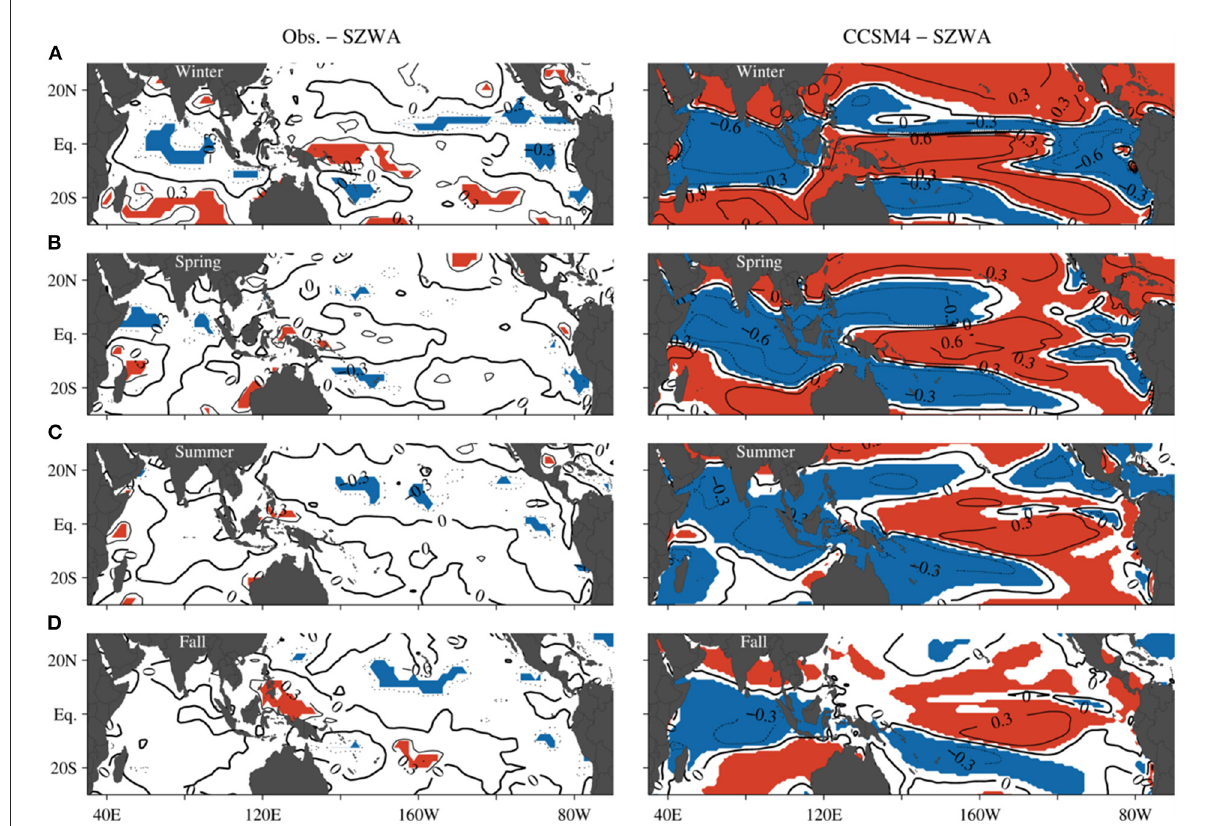
FIGURE9 Comparison of observed (left column) and simulated (right column) lag correlations between the SZWA over the far western equatorial Pacific in fall and the tropical Indo-Pacific SZWA in the following four seasons during the positive phases of the decadal variability (from 1948 to 2009 in the observation). (A) Winter (December to February). (B) Spring (March to May). (C) Summer (June to August). (D) Autumn (September to November). The contour interval is 0.3. Red and blue shades indicate 95% confidence level of positive and negative correlation,